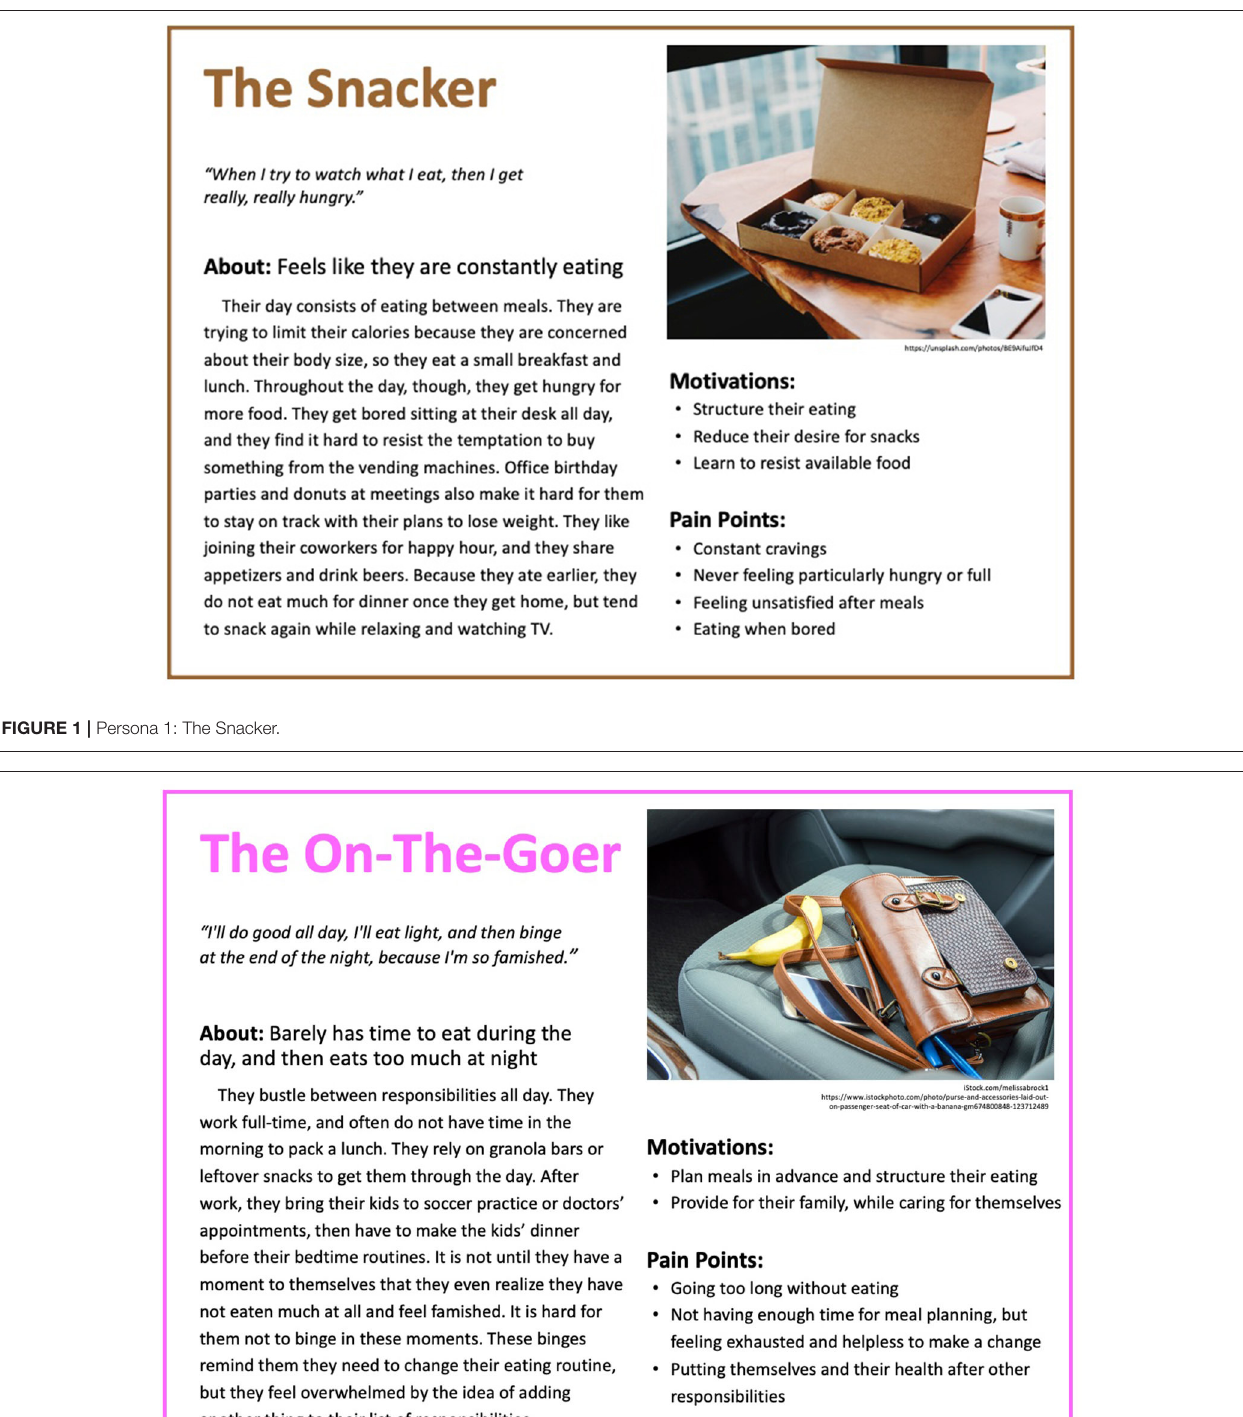
FIGURE 2 | Persona 2: The On-The-Goer. up on extra groceries, but their roommates always share their leftovers and leave snacks which are hard to resist on the counter. They struggle with depression and anxiety; while the initial